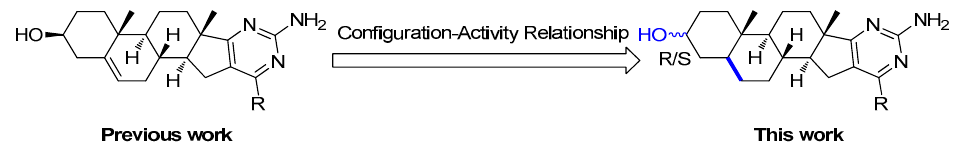
Figure 2. Design strategy of steroidal[17,16- d ]pyrimidines.